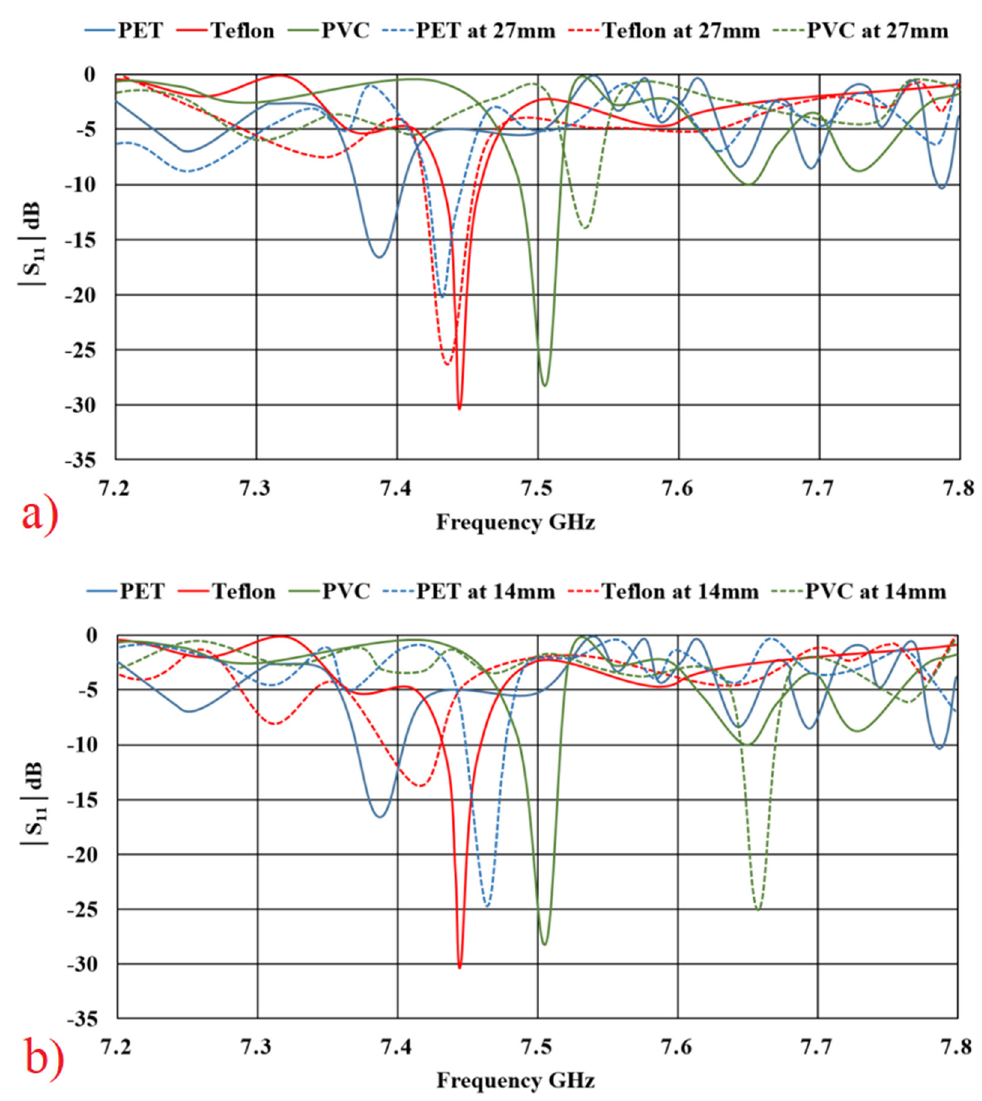
Figure 15. Operating at 7.45 GHz, reflection coefficients of E-shaped flexible polymer substrate antennas on PET, Teflon, and PVC substrates non-bent and with bending: ( a ) 27 mm, ( b ) 14 mm.